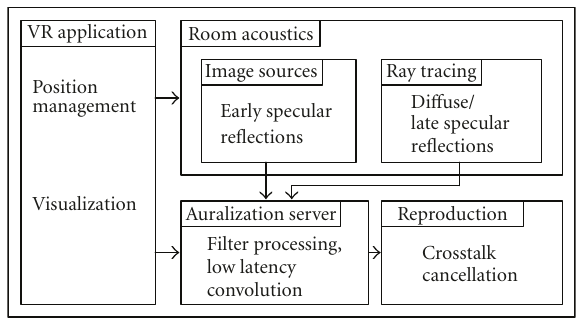
Figure 1: System